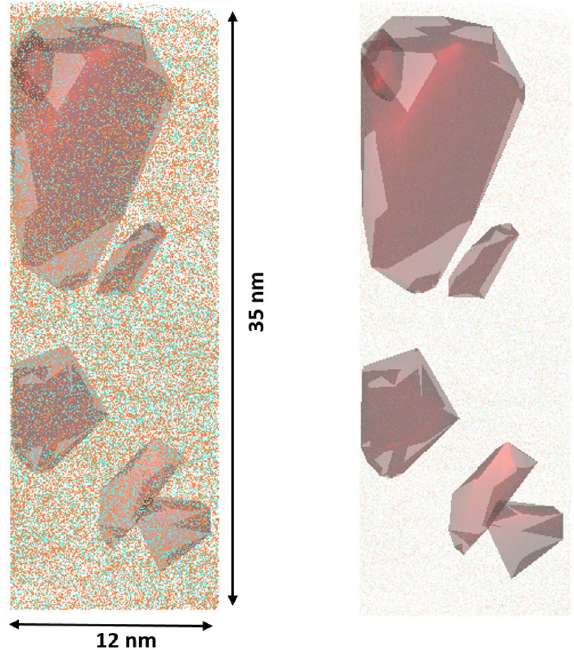
Figure 8. The sugar cluster is visualized by red areas into a defined box with a volume of 12 × 12 × 35 nm. In total six clusters with varied sizes and shapes can be identified in this